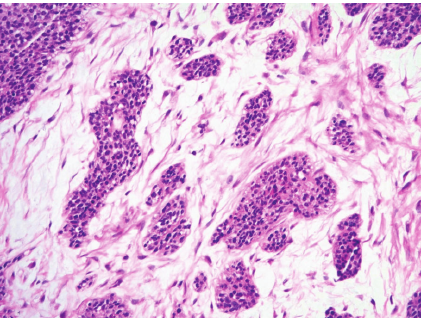
Figure 1: The excised supraclavicular lymph node showed the characteristic morphology of DSRCT. Cohesive nests of undif- ferentiated small blue cells with some degree of nuclear atypia were seen embedded within moderately cellular fibrous stroma (histopathology, hematoxylin and eosin stain,